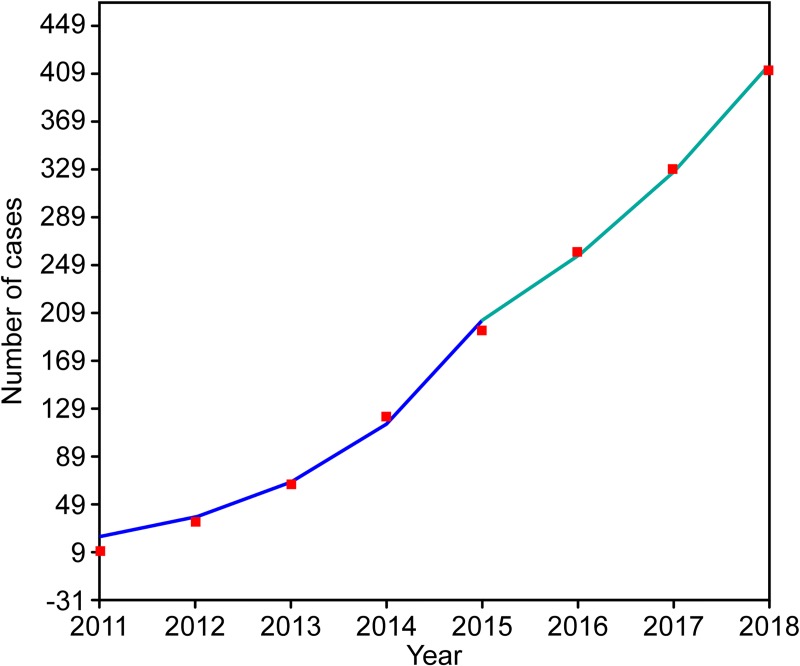
Trend of the incidence of SFTS between 2011 and 2018 shown by the joinpoint regression.The red squares denote the yearly cumulative cases, and the blue line is the slope of the APC, the annual percent change.